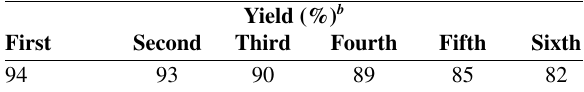
@ SiO O nanoparticles 3 4 2